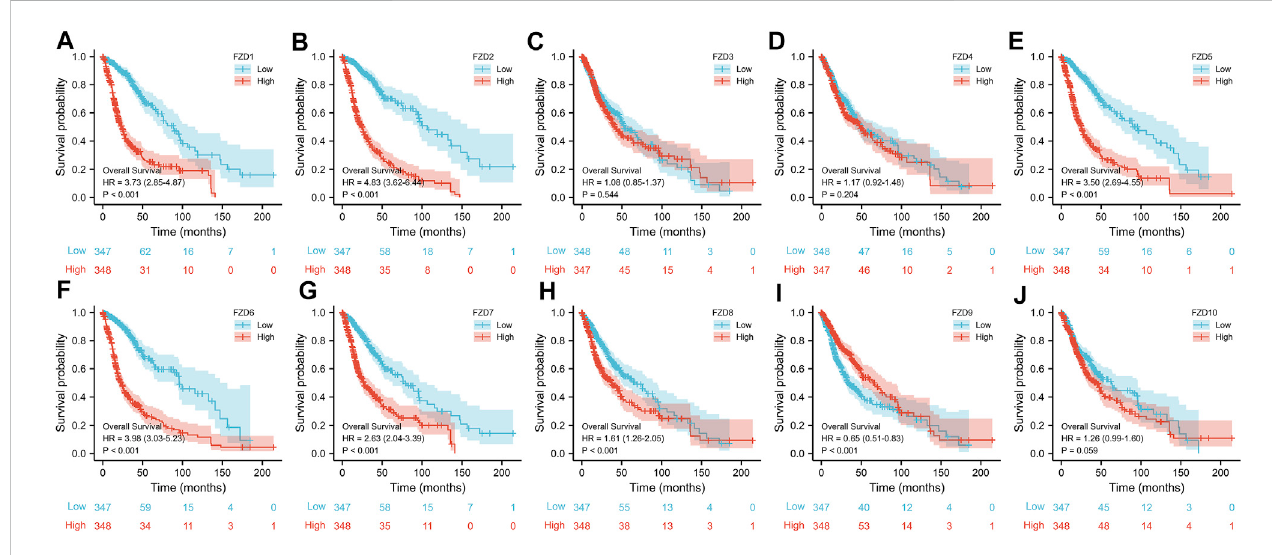
FIGURE 2 Kaplan-Meier (KM) curves of the association between FZD expression and overall survival. (A – J) KM curves of